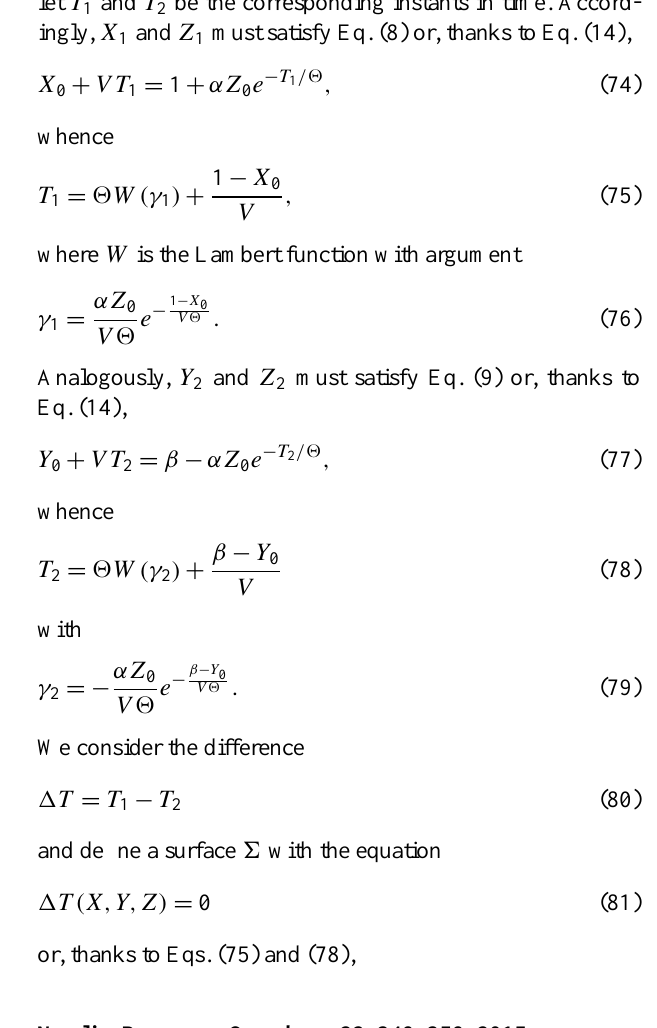
Figure 4. The faces AC D and B C D of T and their subsets, which determine the sequence of slipping modes and the moment rate of the seismic event ( α = 1, β = 1, (cid:15) =